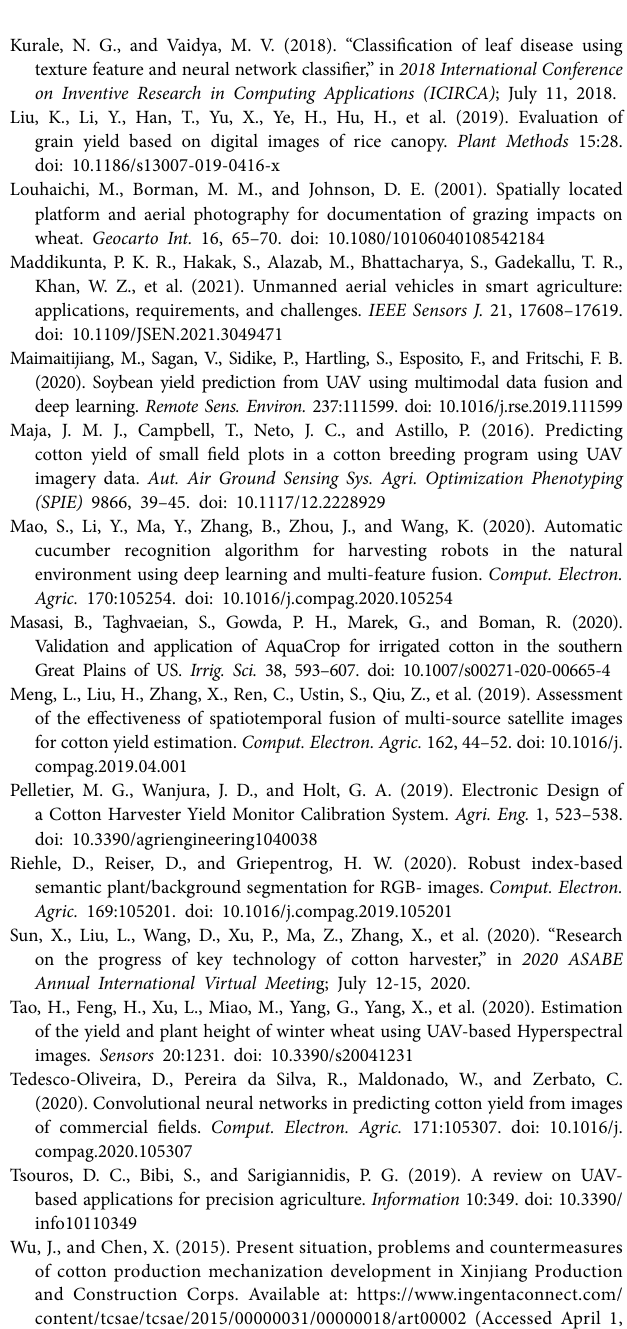
Supplementary Figure 1 | Cotton yield inversion based on 2020’s UAV RGB imagery: (A) make cotton yield inversion map based on measured yield; (B) make cotton yield inversion map based on the vegetation indices and texture features by KRR model; (C) make cotton yield inversion map based on the vegetation indices and texture features by ELM model. Supplementary Figure 2 | Difference of texture features under different treatments. Supplementary Figure 3 | Comparison of results of different modeling